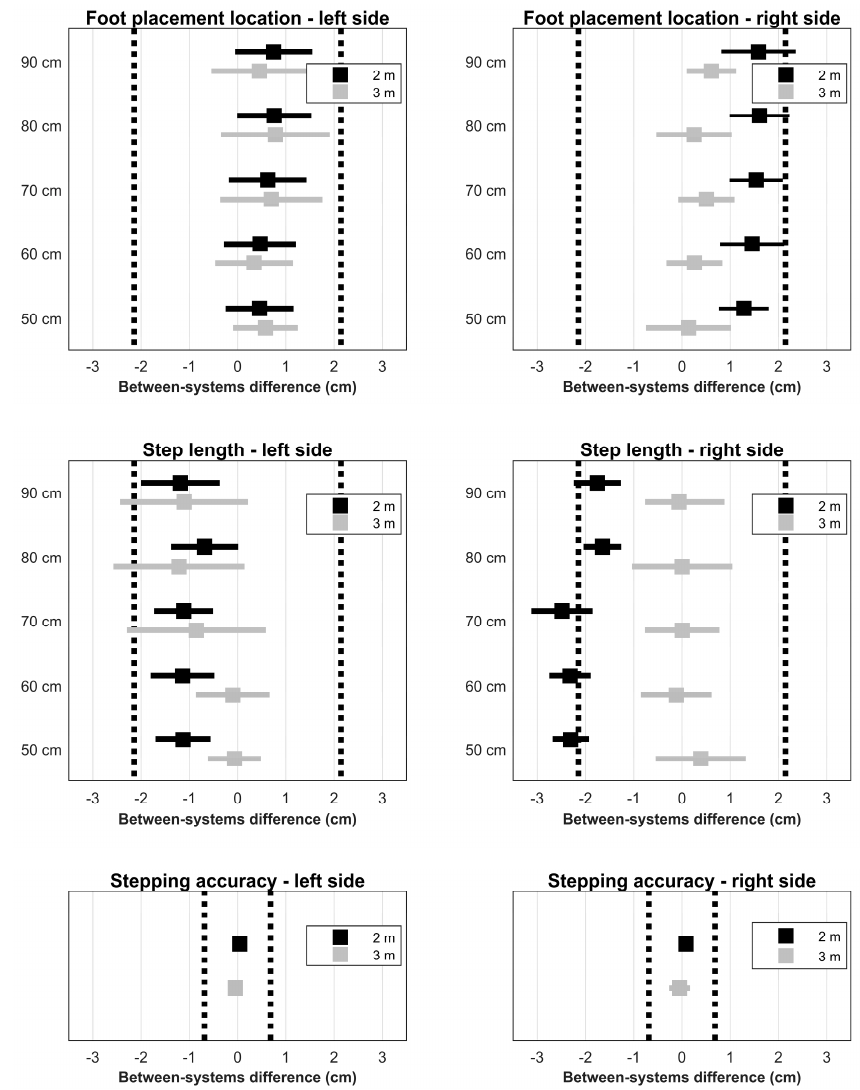
Figure 2. Results of the two one-sided t -tests, showing the between-systems differences and the 90% confidence intervals of all conditions for foot placement location, step length, and stepping accuracy.